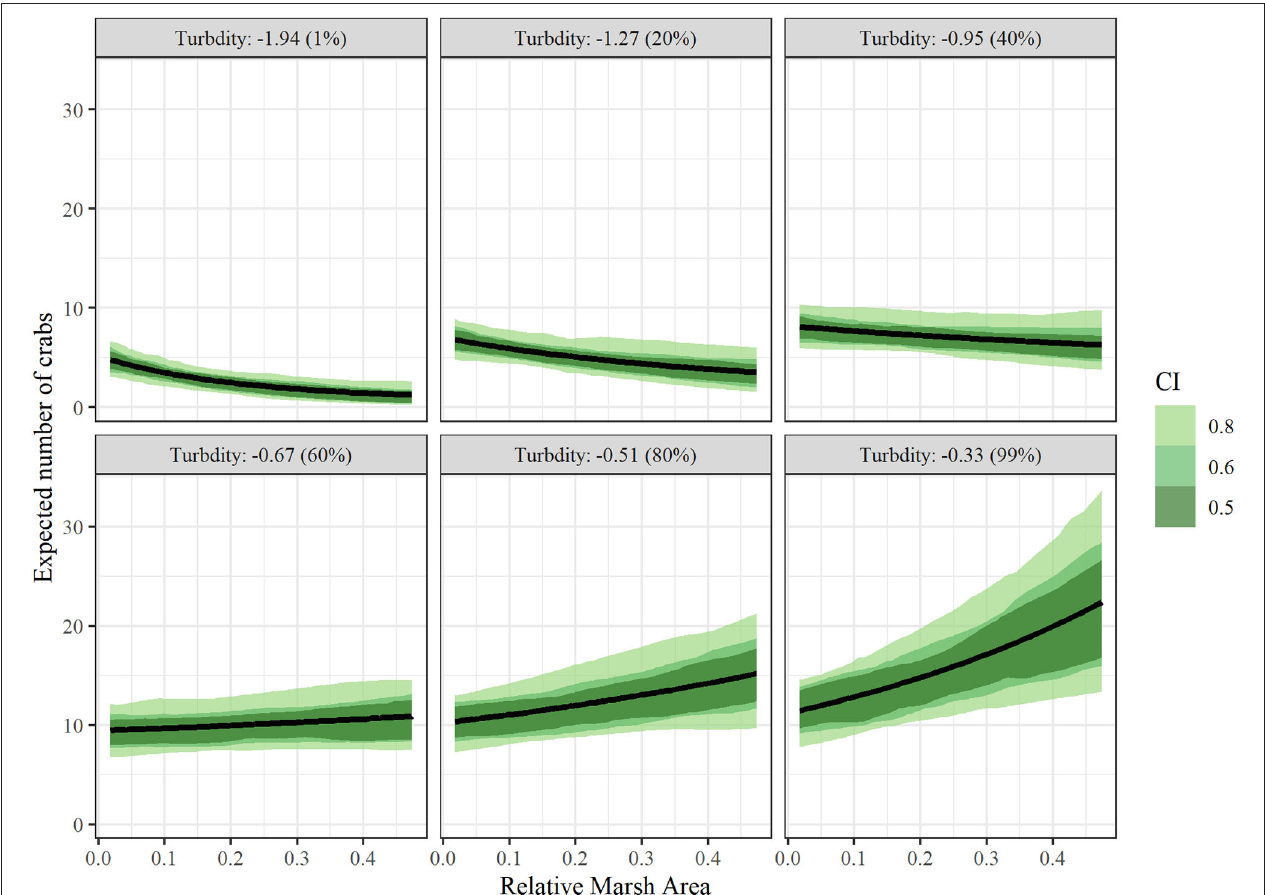
FIGURE 5 | Conditional effects plots depicting relationship between juvenile blue crab abundance per 1000 m towed ( µ cond ) vs relative marsh area (RMA) at turbidity values corresponding to 1, 20, 40, 60, 80, and 99% percentiles to visualize interaction effects between relative marsh area and turbidity on crab abundance. All other continuous variables were held at 0 and categorical variables at the James River (tributary) and post 2008 (management). Colored bands indicate Bayesian confidence bands of µ cond . (See the Drivers of Juvenile Blue Crab Abundance Section for